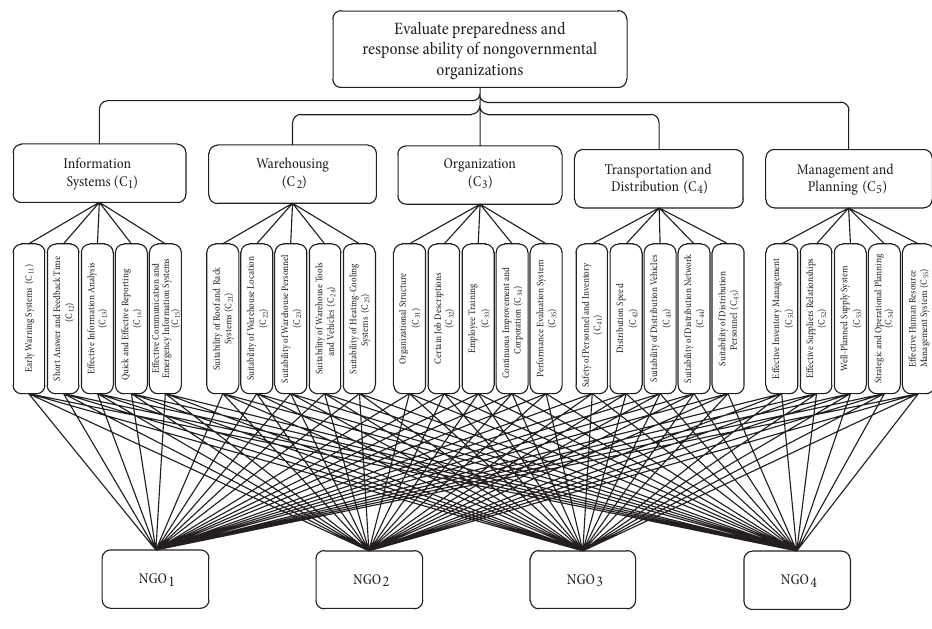
Fig. 3. The hierarchical